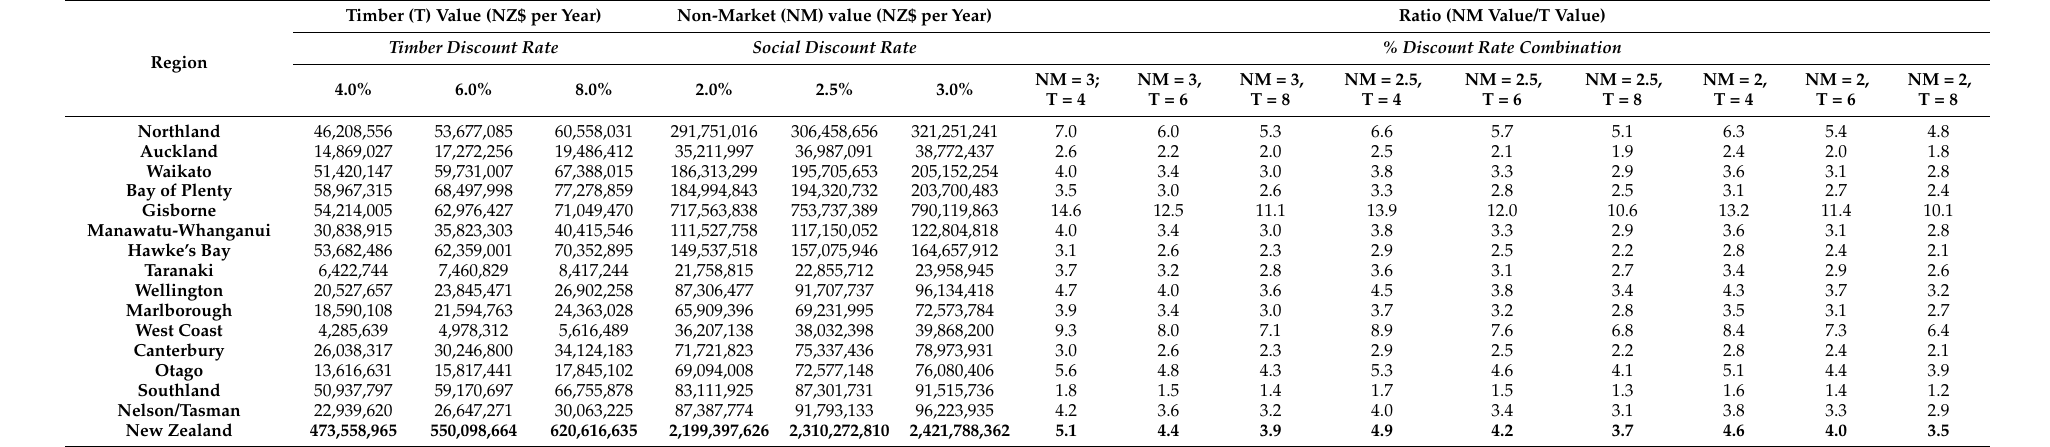
Table 2. Impacts of using different discount rates on timber and non-market ES values and their ratios.